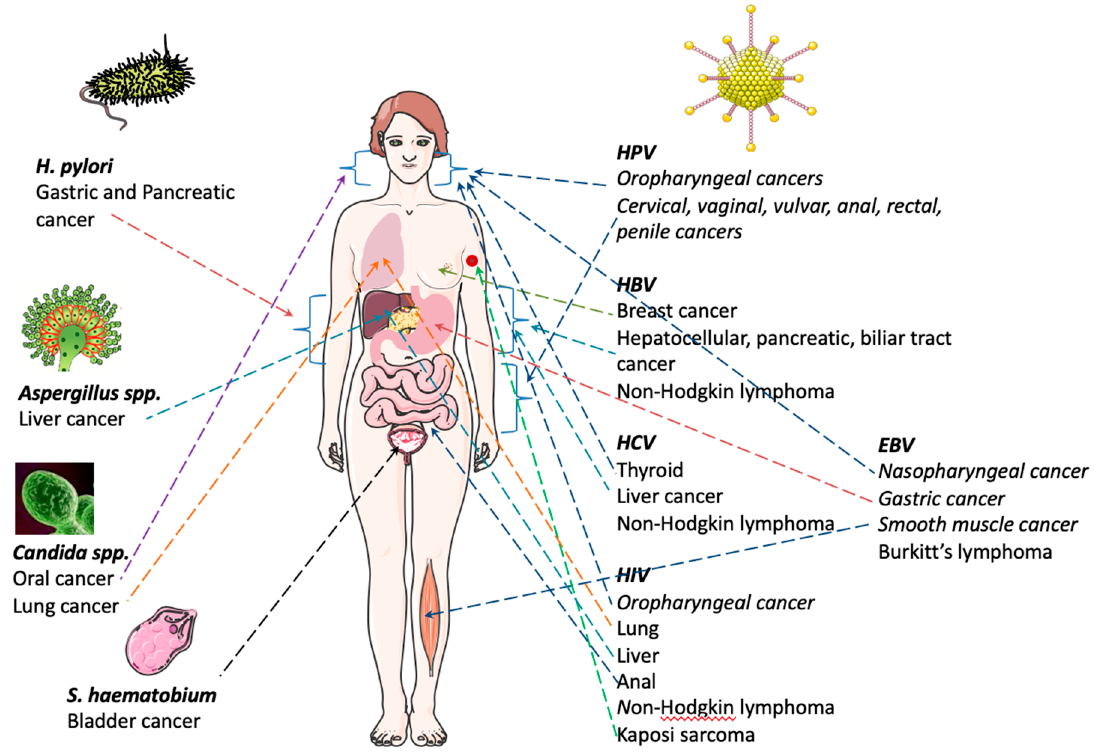
Figure 1. Infectious agents and associated cancer types. This figure was produced, in part, using Servier Medical Art (https://smart.servier.com)